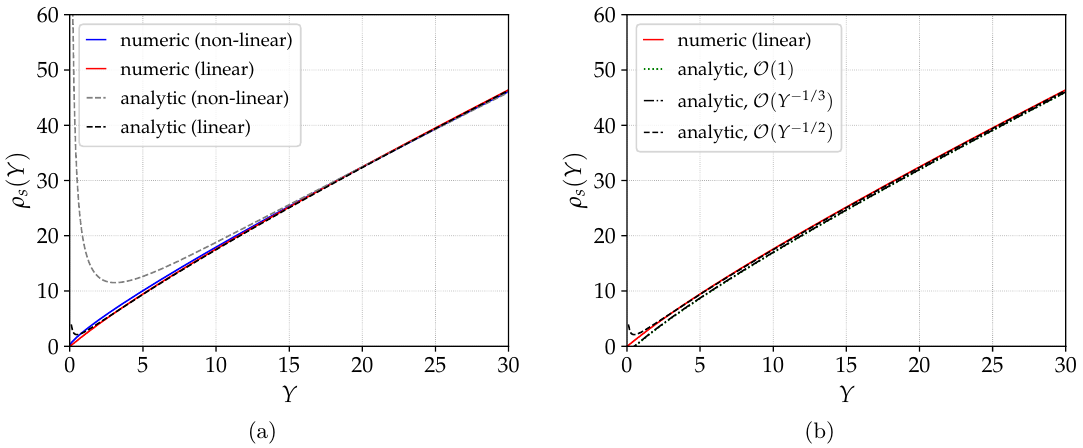
Figure 9. The saturation scale ρ s ( Y ) obtained numerically for the non-linear and linear scenario. The dotted black curve is the analytic result given by eq. (5.75) and